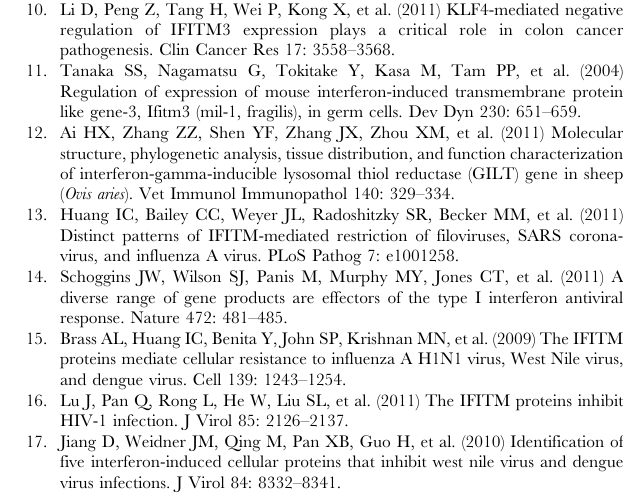
Figure S2 Sequence alignment of the vertebrate IFITM5 genes. Alignment was used to reconstruct the Bayesian tree in Figure 2B. Figure S3 Sequence alignment of the vertebrate IFITM10 genes. Alignment was used to reconstruct the Bayesian tree in Figure 2C. Figure S4 Sequence alignment of the mammalian IR- IFITM genes. Alignment was used to reconstruct the phyloge- netic trees shown in Figure 3. The abbreviations were adopted from the species names in Table 1. Figure S5 Proteins sequence alignments of IFITM5, IFITM10 and IR-IFITM genes. Consensus (identical) amino acids are shown in the bottom line (Similarity Groups: 1, DN; 2, EQ; 3, ST; 4, KR; 5, FYW; 6, LIVM). Black or gray shading indicates conservation and similarity, respectively. Figure S6 Numbers of non-synonymous (n) and synon- ymous (s) substitutions in frog IFITM10 and IFITM10- like genes. Actual numbers of n/s changes and v values (dN/dS,